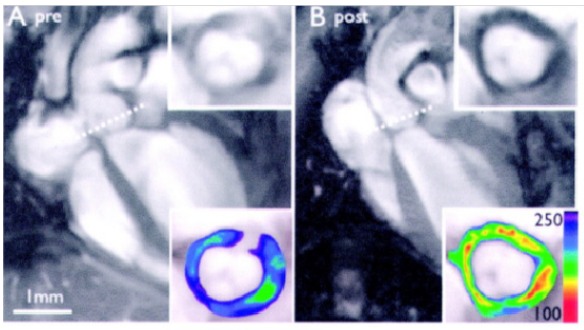
Figure 7. In vivo imaging of atherosclerotic inflammation using a peptide targeting VCAM-1 (VINP-28) performed in the aortic root of apoE − / − mice prior to ( A ) and after ( B ) administration of VINP-28. Considerable decrease in signal intensity is seen on the transverse MR images of the aortic root wall (grayscale insets). The contrast-to-noise ratio is significantly increased after the administration of the probe (color insets), demonstrating noninvasive imaging of VCAM-1–expression on endothelial cells and macrophages of atherosclerotic vessel segments (adapted from Nahrendorf)